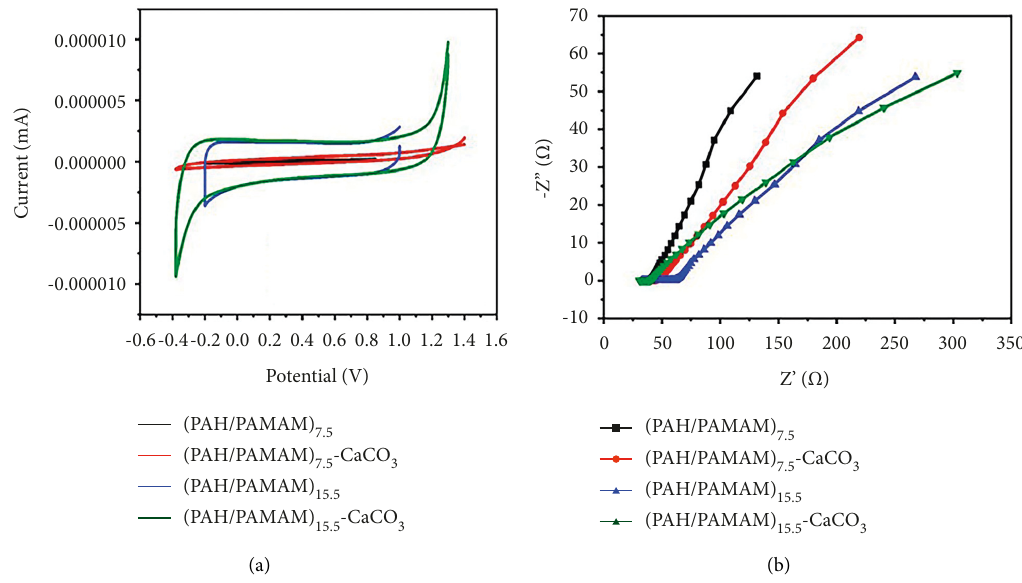
Figure 9: Electrical properties (a), cyclic voltammograms, and (b) Nyquist plot (at a scan rate of 5mVs − 1 ) of different films in 0.1M PBS.